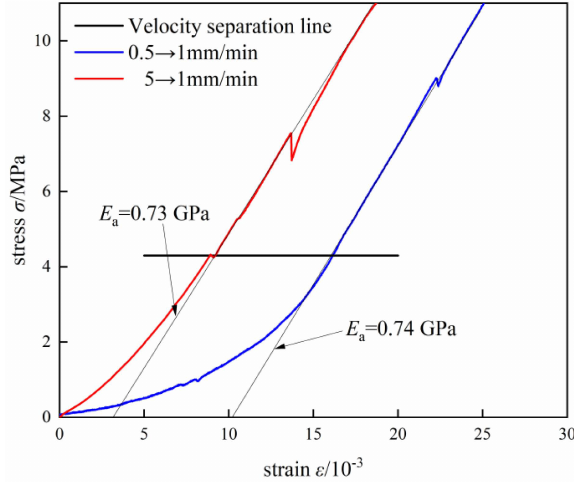
Figure 10. Comparison diagram of stress–strain in elastic stage of velocity line after same sudden change speed.